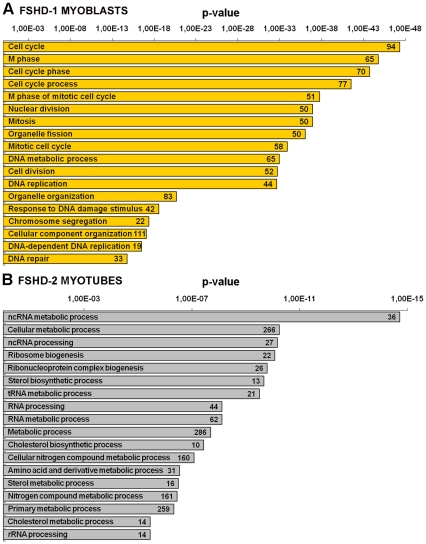
Selected gene classifications according to biological processes.Biological processes significantly enriched in the set of genes identified by microarray as up- or down-regulated in A) FSHD-1 myoblasts, and B) in FSHD-2 myotubes, and categorized in the DAVID program. Numbers in the bars indicate the number of genes assigned to each gene ontology term. p-value <0.05.